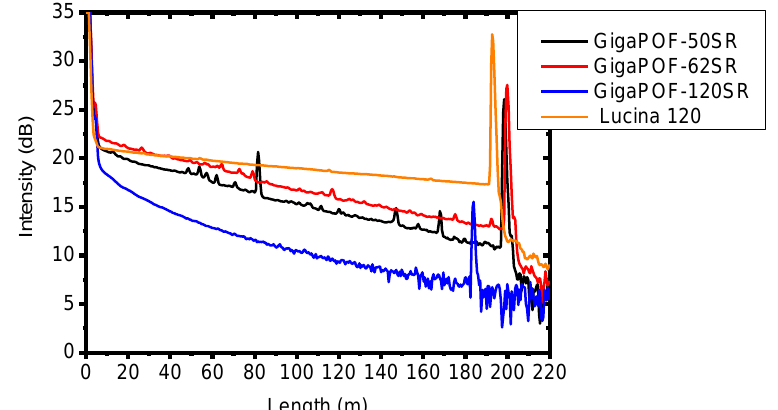
Figure 6. Optical backscattering measurement of the